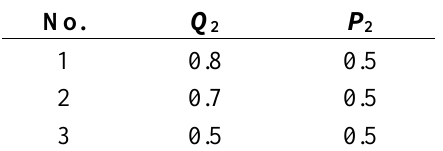
Table 3. Individual supply curve coefficients.